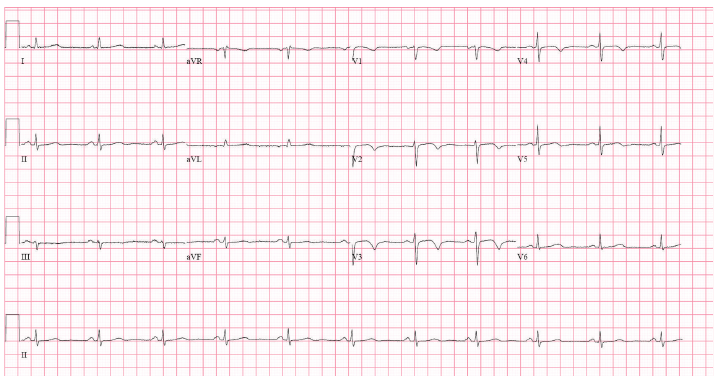
Figure 2: ECG obtained while patient experienced chest pain during initial rituximab infusion, which demonstrates new-onset deep T- inversion in anterior precordial leads V2 to